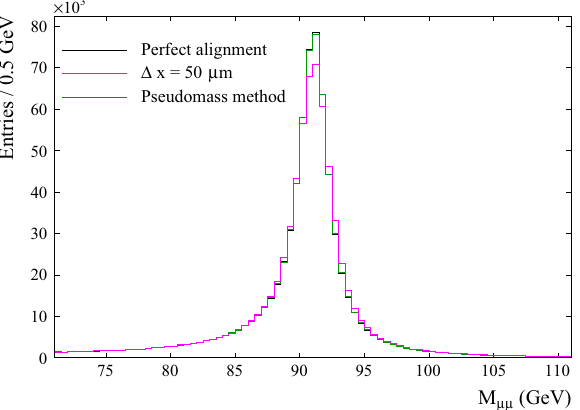
the pseudomass corrections (green), and the unbiased distribution, with no mis-alignment applied